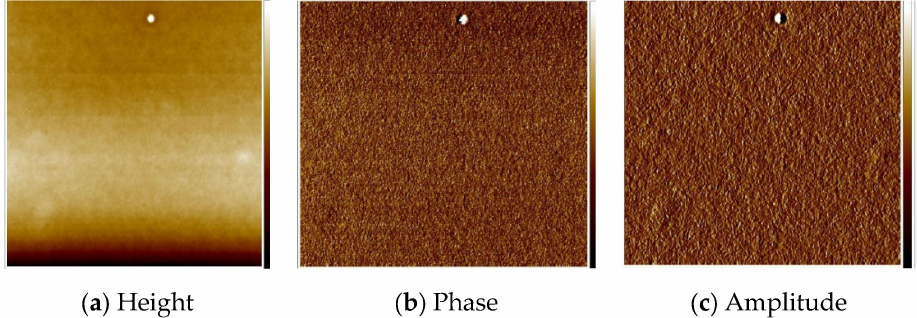
Figure 15. AFM of L2/ Si, R q = 4.87 nm, R a = 3.63 nm, thermal vapor deposition, scan size 10 µ m.